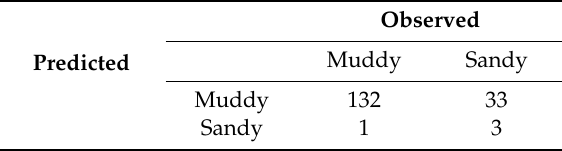
Table A12. Quantitative muddy / sandy S-LOO CV error matrix.